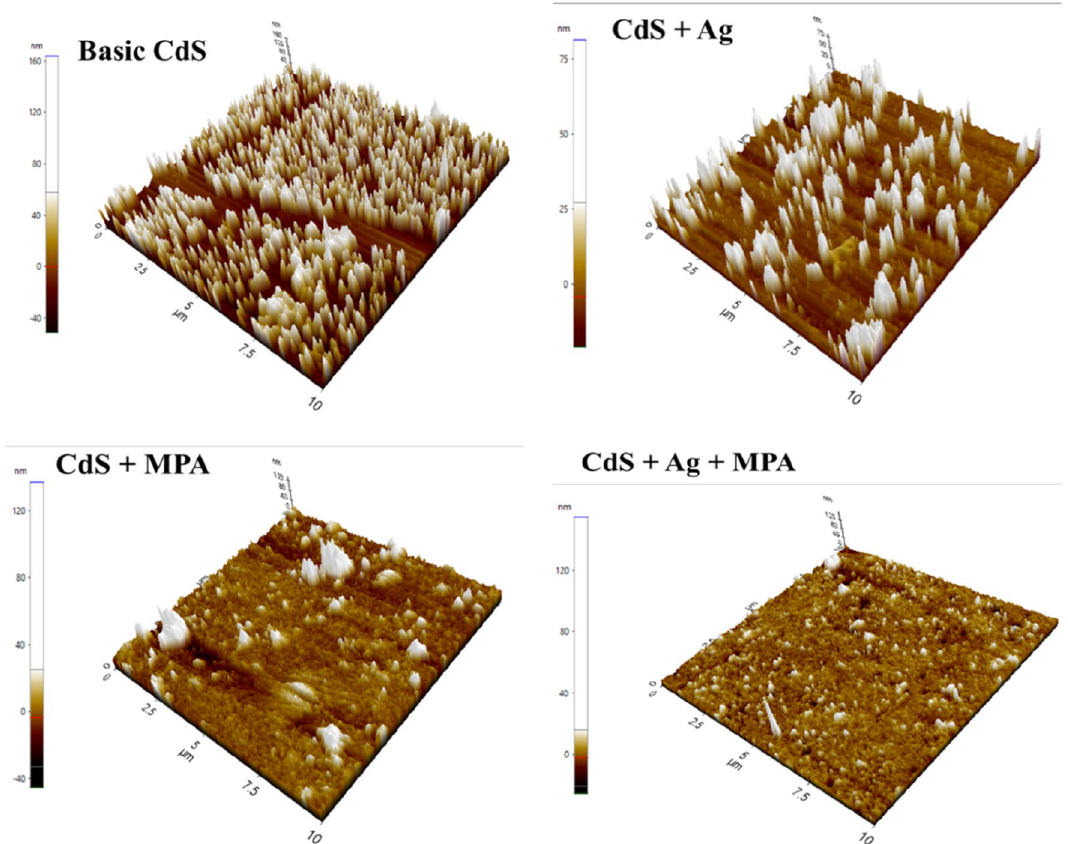
Figure 7. 3D AFM images (10 × 10 μm) for thin film synthesis at: ( a ) CdS, ( b ) CdS + Ag, ( c ) CdS + MPA, ( d ) CdS + Ag + MPA.